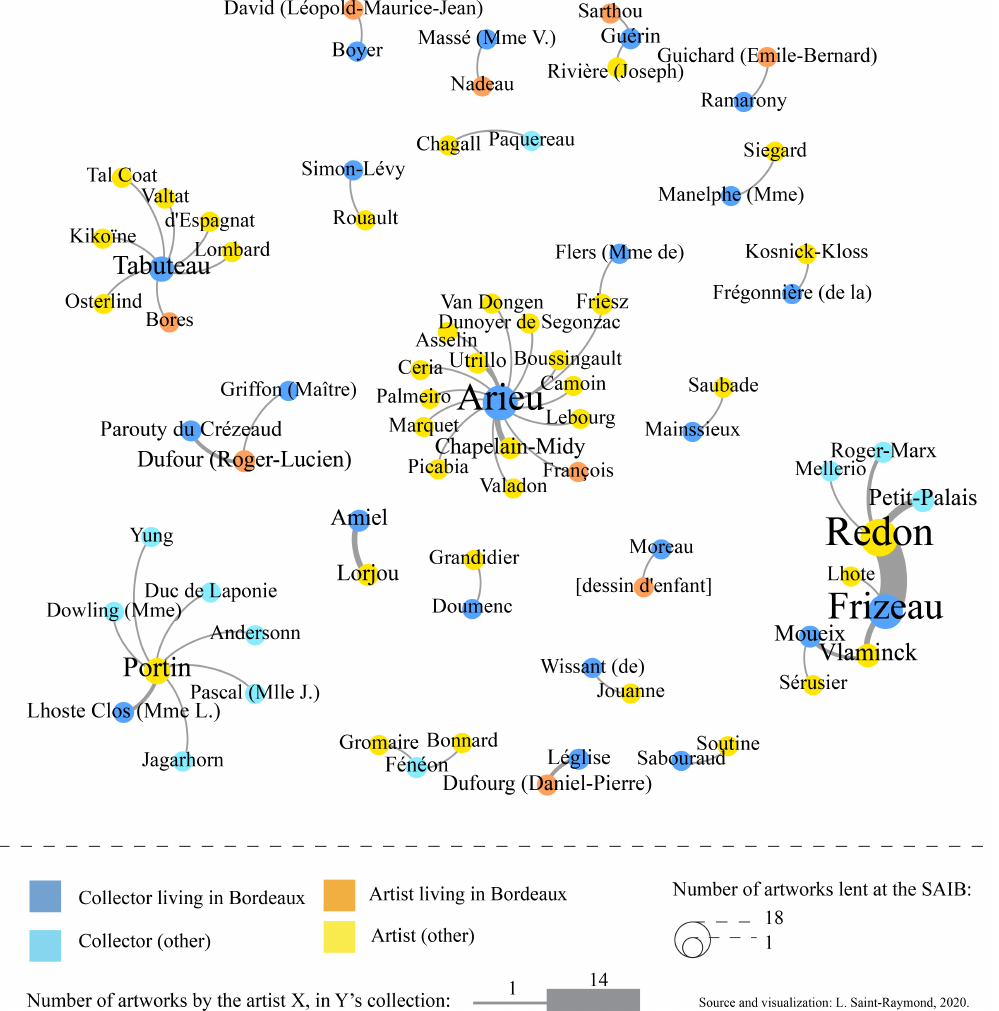
Figure 14. Networks of the artworks, lent by (identified) collectors at the SAIB,